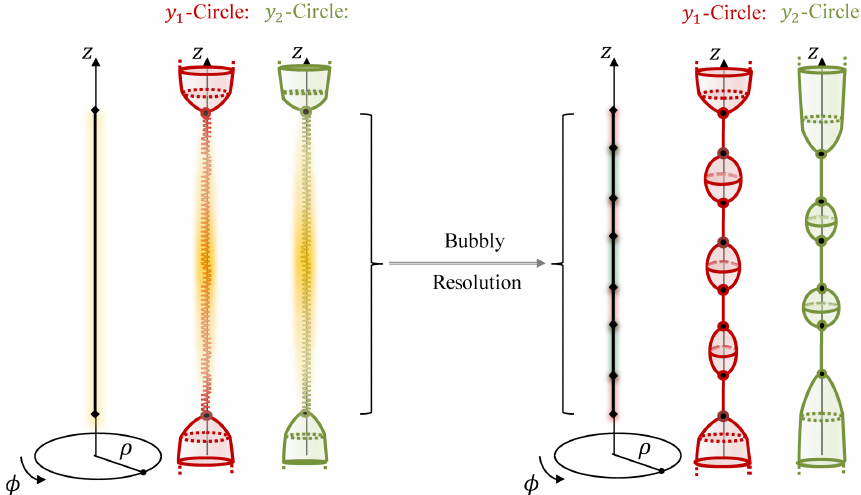
Figure 2. In the first figure we consider a coarse graining of the rod sources to obtain a singular solution, dubbed bag spacetime. The singularity is resolved by Weyl star